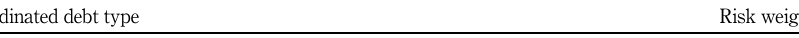
Table 4. Basel IV risk weights for subordinated debt and equity